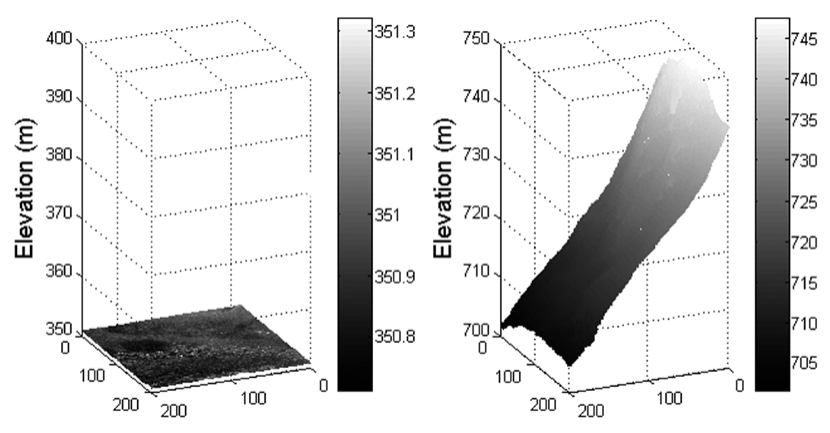
Fig. 1. LiDAR DEMs with a spatial resolution of 0.5 m covering 100*100 meters areas. On the left is the flat area with less topographic deviation and on the right is the steep